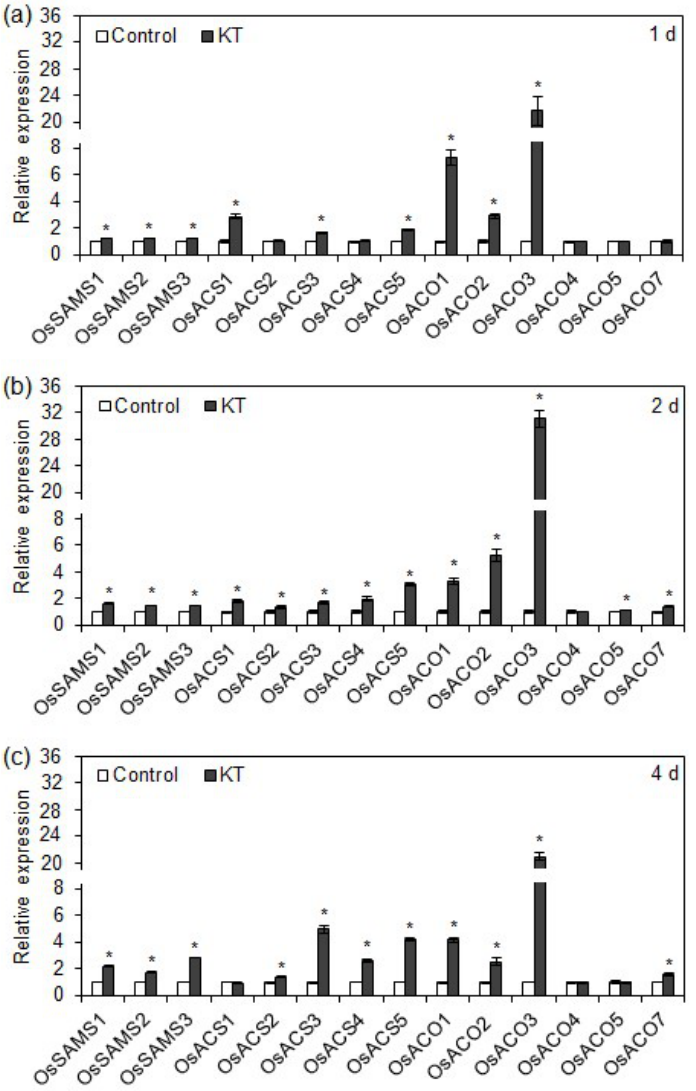
Figure 3. Transcriptional regulation by exogenous KT on ethylene biosynthesis genes in rice seminal roots. Germinated rice seeds were incubated with a solution of 40 nM KT or distilled water as a control. Seminal roots were collected for qRT-PCR (quantitative real-time PCR) analysis after 1 day ( a ), 2 days ( b ), and 4 days ( c ). Data are presented as means ± SE. Three biological replicates with three technical replicates were included in the statistical analysis and error range analysis. Asterisks indicate significant differences ( p < 0.05) in expression of the same genes in the control and KT treatment conditions.